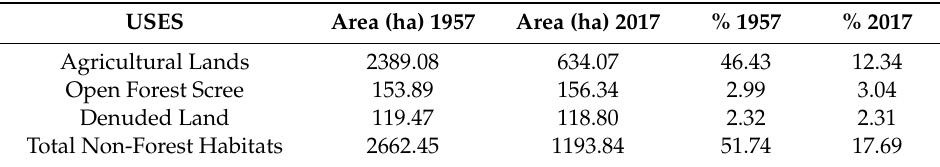
Table 2. Non-forest habitats in terms of landscape composition and